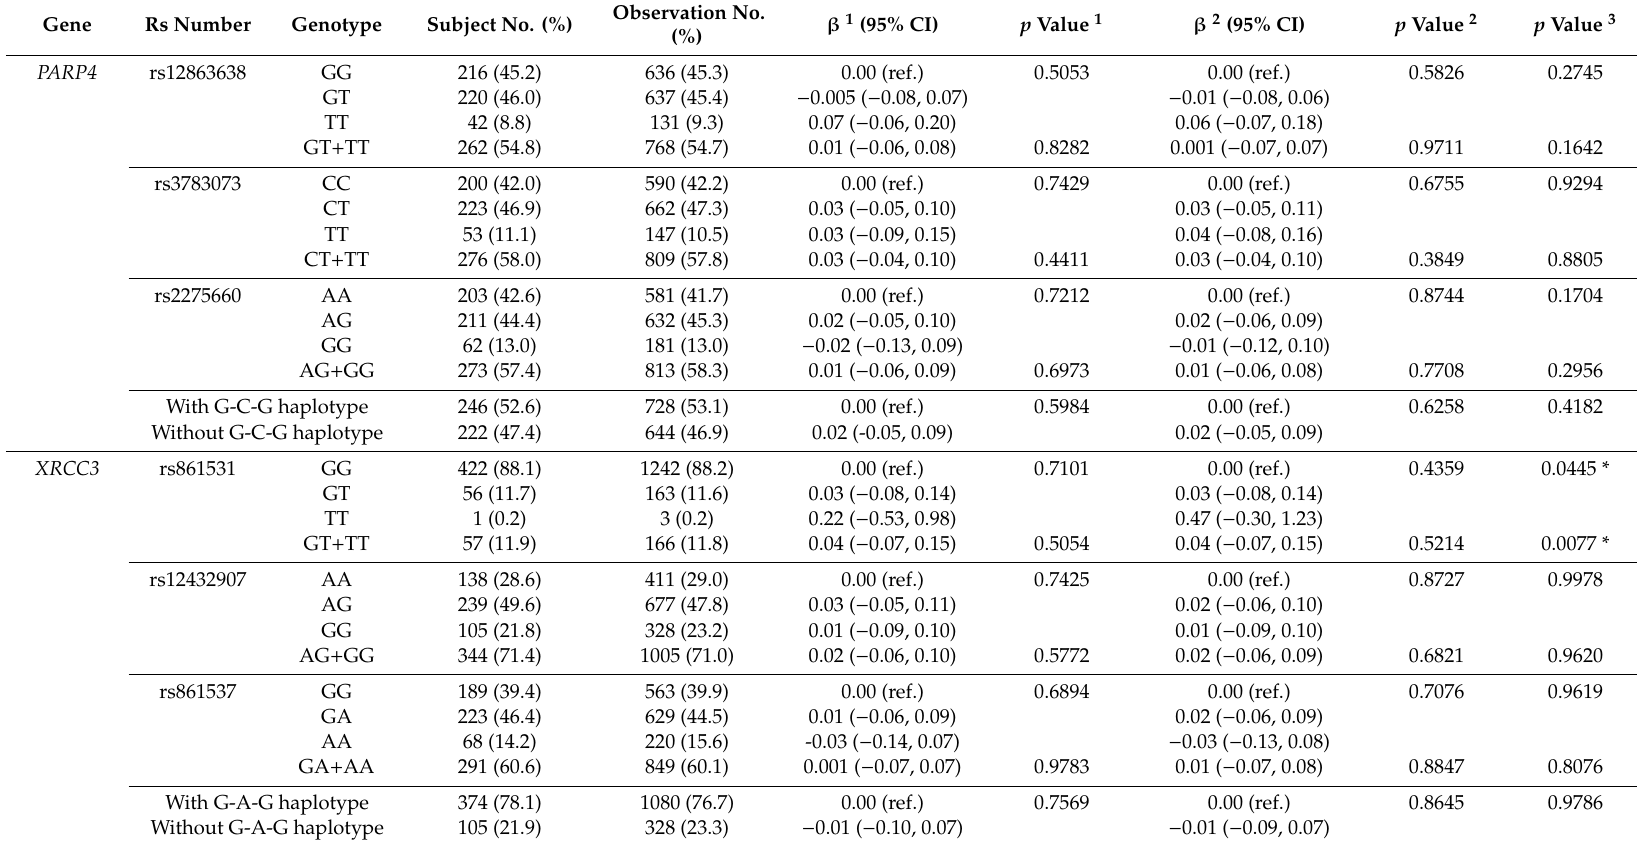
Table 6. The e ff ects of repair gene polymorphisms and combined diplotypes on oxidative